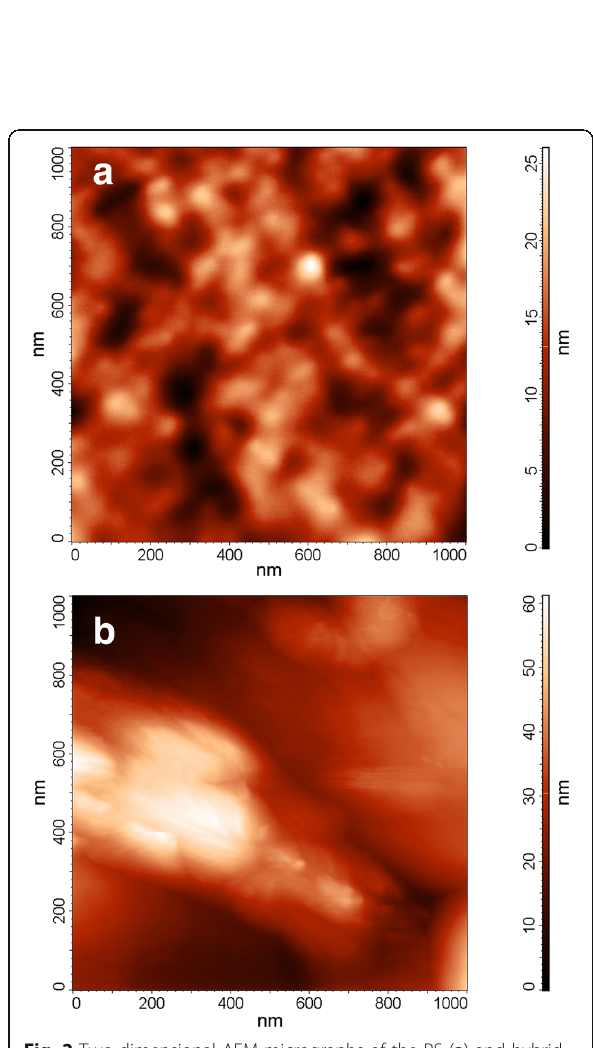
Fig. 2 Two-dimensional AFM micrographs of the PS ( a ) and hybrid PS – RGO structures ( b )